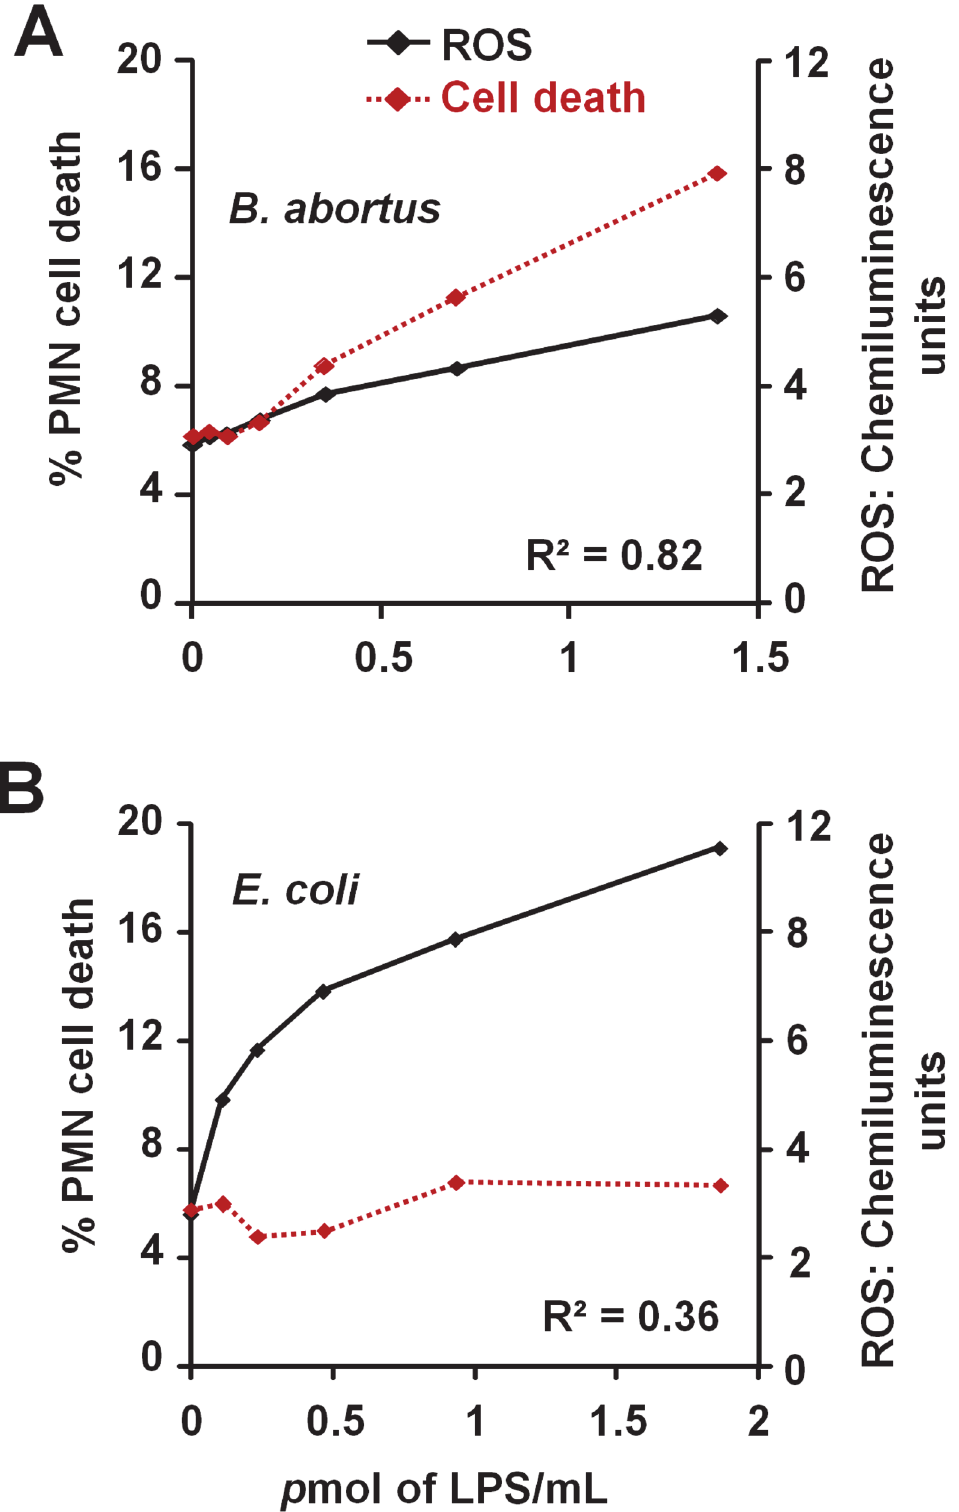
Fig 10. Br -LPS-induced PMN cell death correlates with low ROS formation. Purified human PMNs were seeded on serum-uncoated plates and treated with various concentrations of Br- LPS or Ec- LPS for 6.5 h. (A) ROS kinetics production was monitored for 90 minutes by luminol-amplified